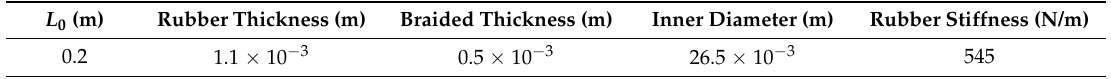
Table 3. The initial specifications of the new contraction PMA.